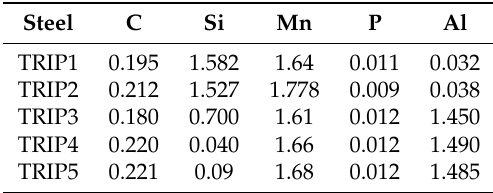
Table 1. Chemical composition (wt%) of the CMnSi (TRIP1), CMnSiAl (TRIP2), CMnAl (TRIP3), CMnAl (TRIP4), and CMnSiAl (TRIP5) TRIP